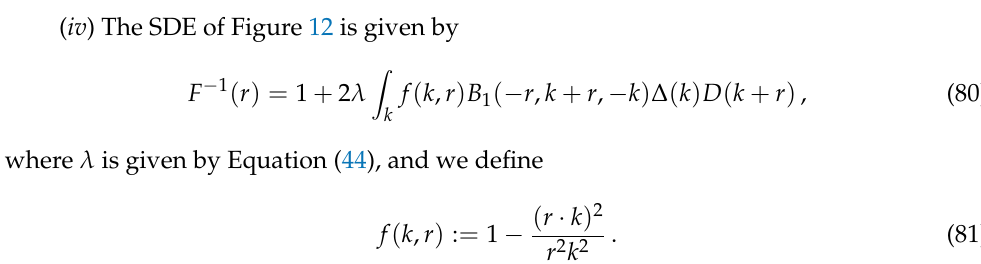
Figure 12. Top: SDE governing the momentum evolution of the ghost propagator. Bottom: SDE for the ghost–gluon vertex, I Γ ν ( r , q , p )